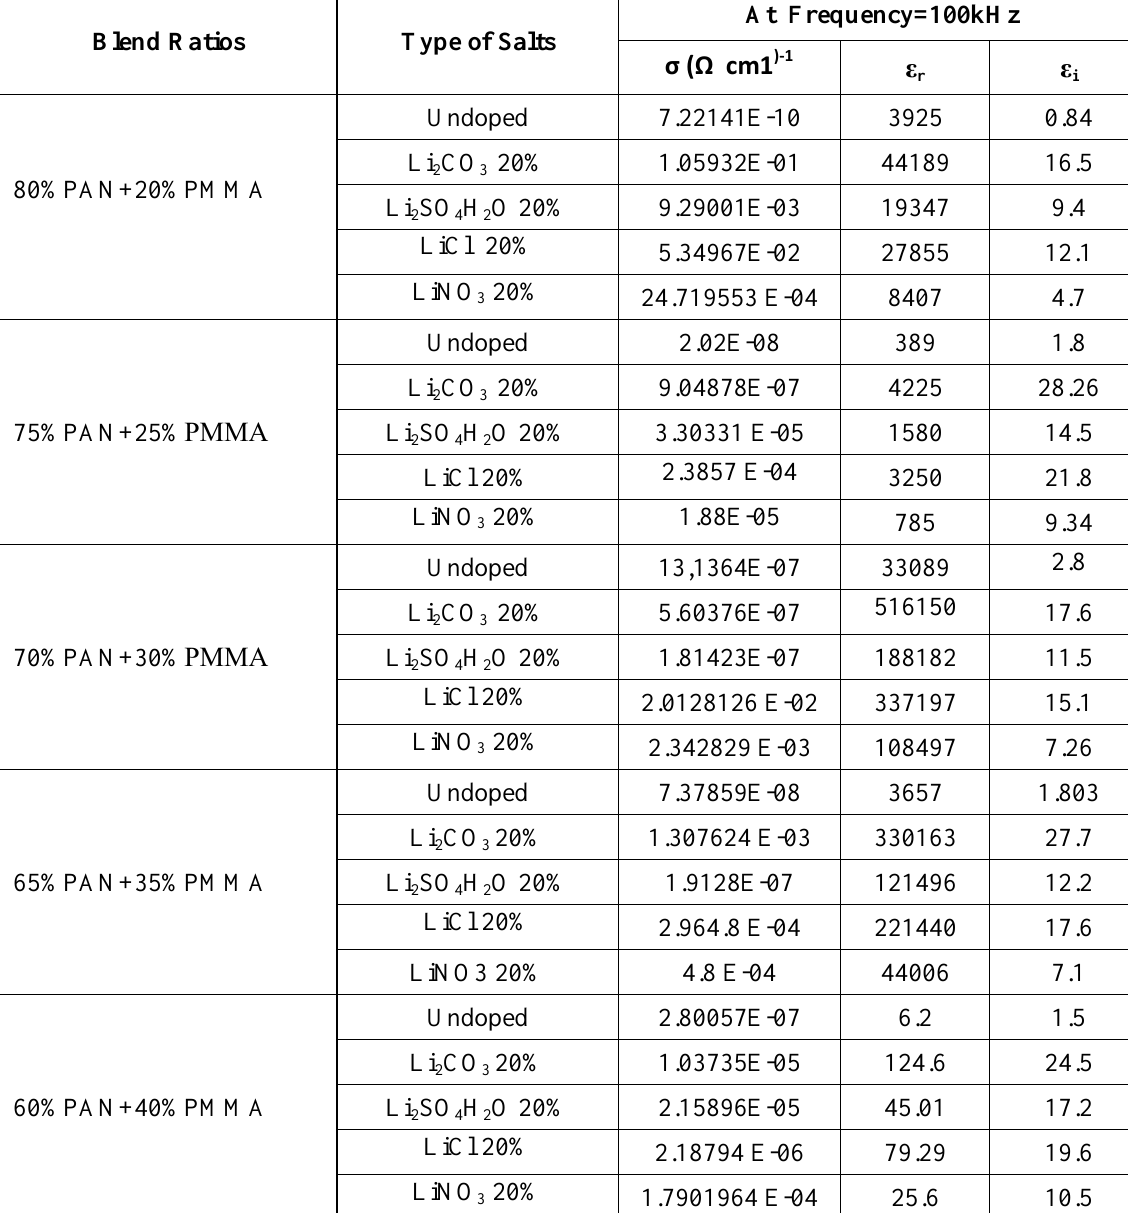
(ω), the real dielectric constant (ε a.c ) of undoped (PMMA+PAN) at different blends ratios and i doped with various lithium salt.